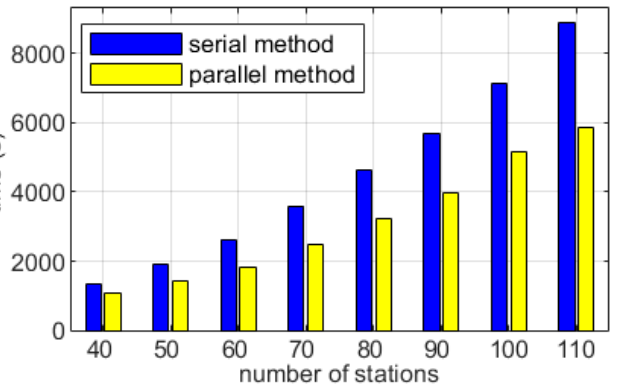
Figure 6. Serial and parallel computational time for satellite orbit determination with different number of stations. number of